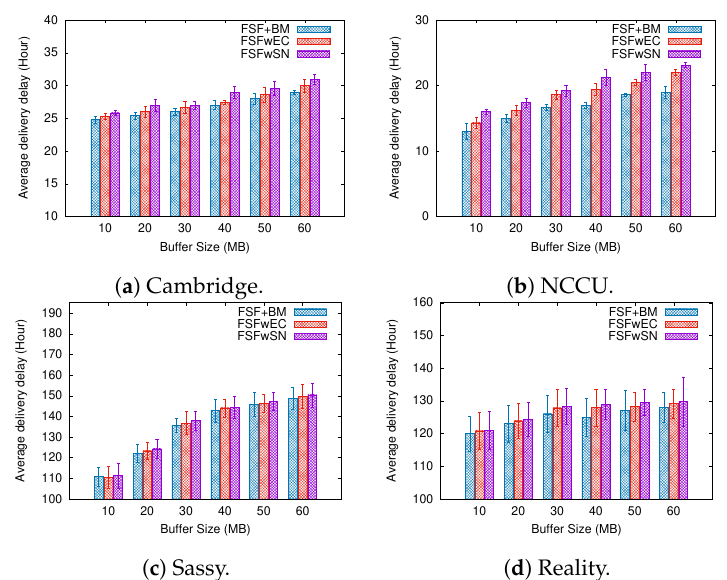
Figure 15. Delivery delay when varying the buffer size.